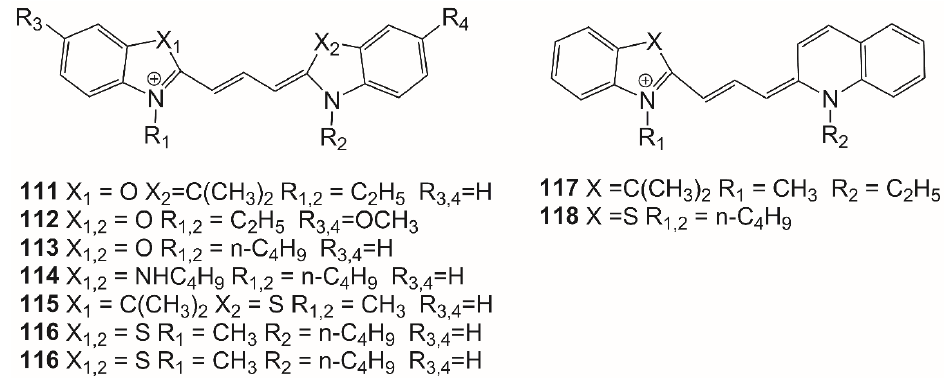
Figure 24. Structures of symmetrical and unsymmetrical cyanines 111–118 .